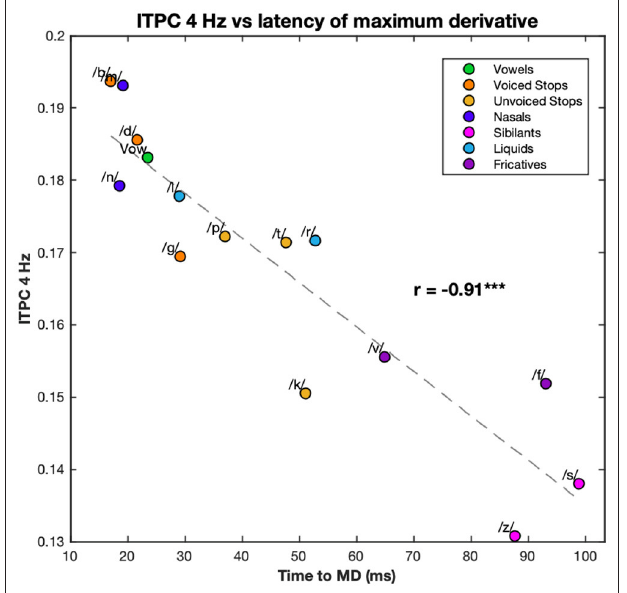
FIGURE 6 | Correlation between the 4 Hz ITPC and the latency of the maximum derivative. The values of the ITPC at 4 Hz are plotted against the latencies of the maximum derivative of each syllable. ITPC and maximum derivative values are averaged according to phonemic condition. Each color corresponds to a different condition (see legend). Dashed line represents the line of best fit (least means squares). The correlation coefficient is given above this line. *** p < 0.001.